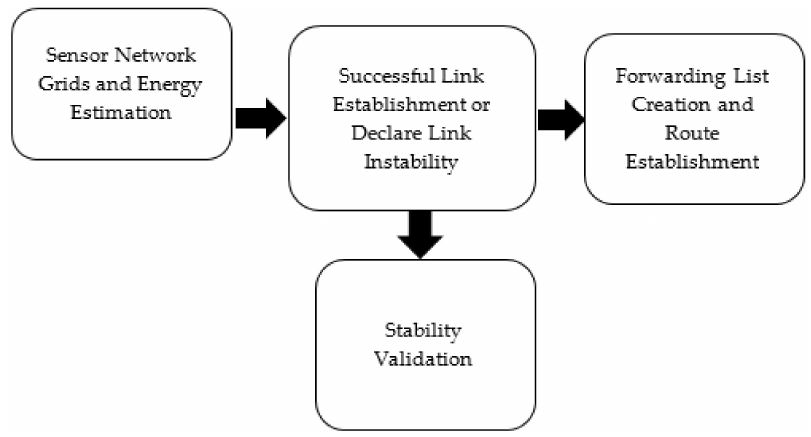
Figure 14. E11-Link stability management and